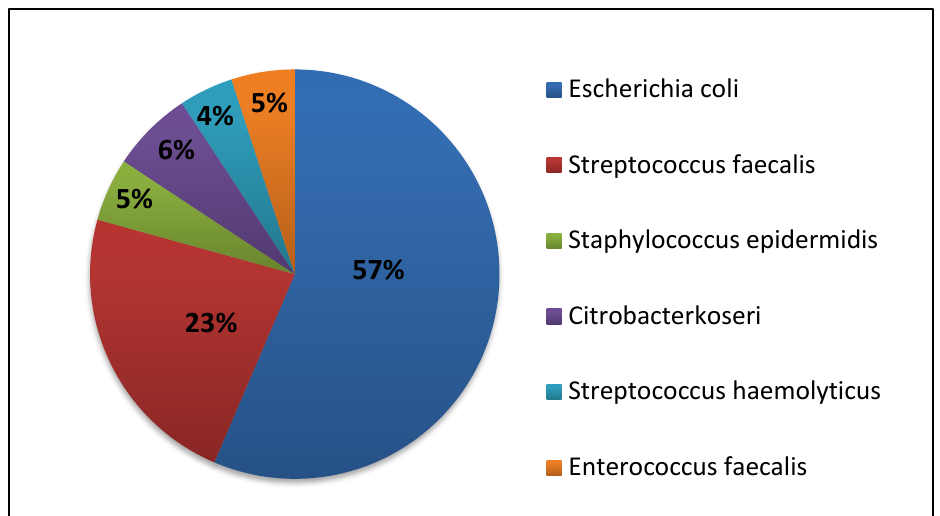
Figure 2. Frequency of urinary bacterial